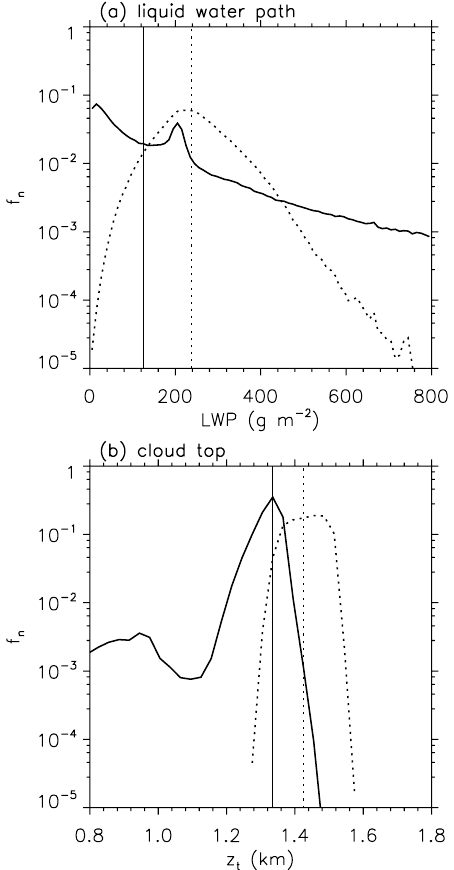
Fig. 2. Normalized probability distribution functions (PDFs) of (a) LWP and (b) cloud top height in the first 8h from experiments D30 (solid lines) and D500 (dotted lines) with corresponding median values indicated by vertical lines. Cloud top in each model column is defined as the uppermost grid point that has cloud water mixing ratio ≥ 0.01gkg − 1